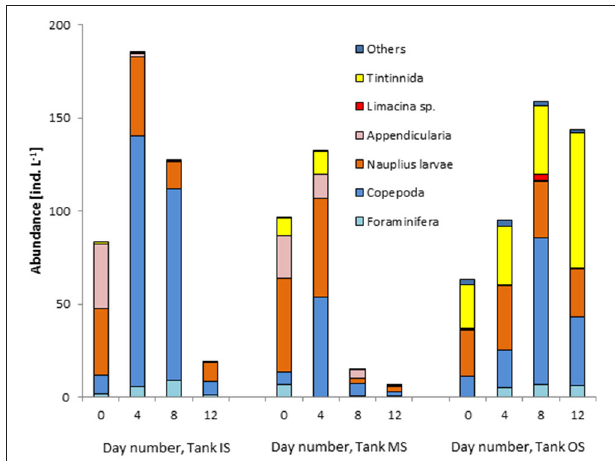
FIGURE 13 | Development of the abundance of the microzooplankton groups in the tank containing water from “inside” (IS) and “outside” (IS) the filament and mixed water (MS) during the summer experiment on cruise